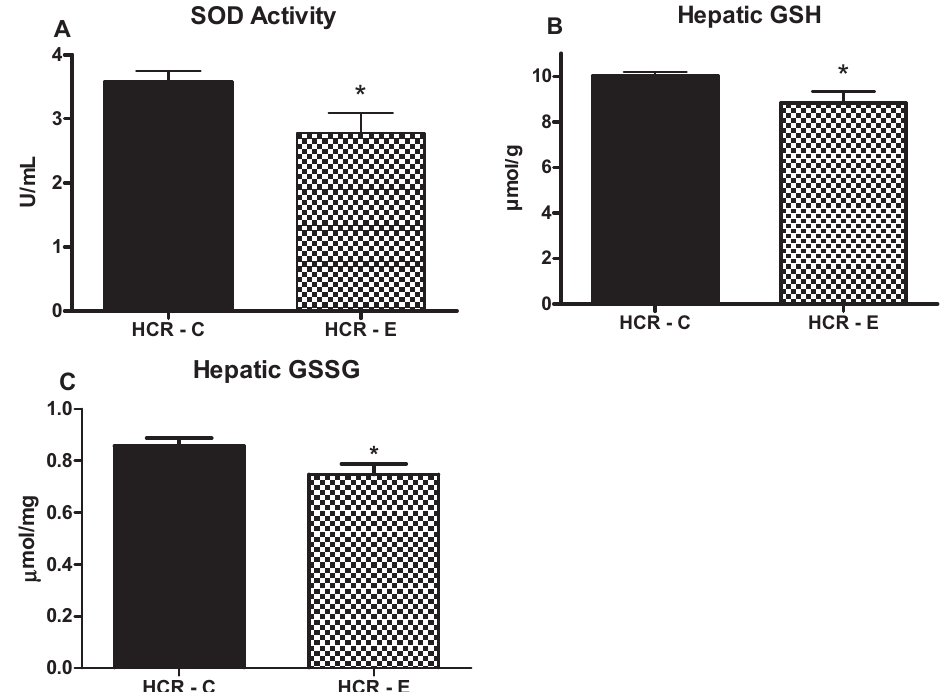
Figure 3. Effects of ethanol consumption on antioxidative markers superoxide dismutase (SOD) activity ( A ); reduced glutathione (GSH) ( B ); and oxidized glutathione (GSSG) ( C ). Values (means ± SE) with * are significantly different ( p < 0.05); n =